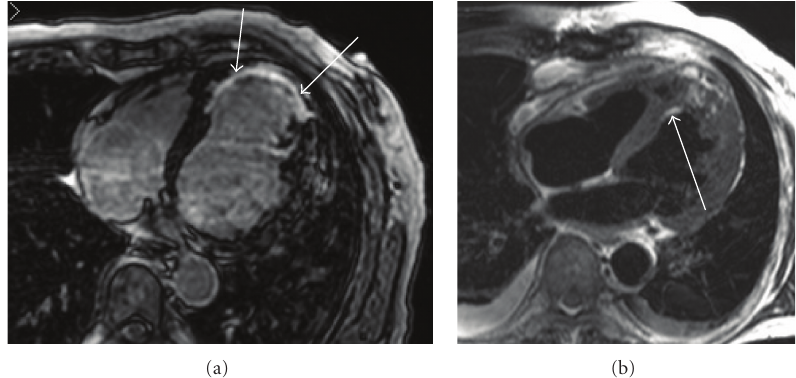
Figure 10: 66-year-old male who has undergone cryoablation for ventricular tachycardia associated with chronic myocardial infarction. Delayed-enhancement MRI (a) visualizes apical myocardial scarring with various transmurality (arrows). T2-weighted MRI (b) shows myocardial edema after ablation (arrow), where nontransmural scarring has been seen in the delayed-enhancement